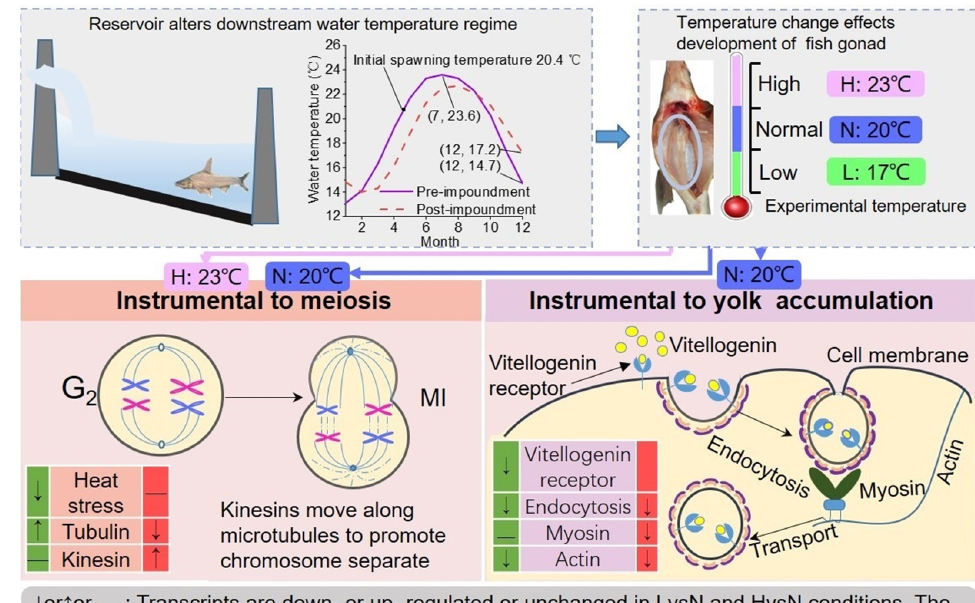
Figure 6. Physiological mechanism of ovary development affected by alterations in water temperature regime in the dammed river.